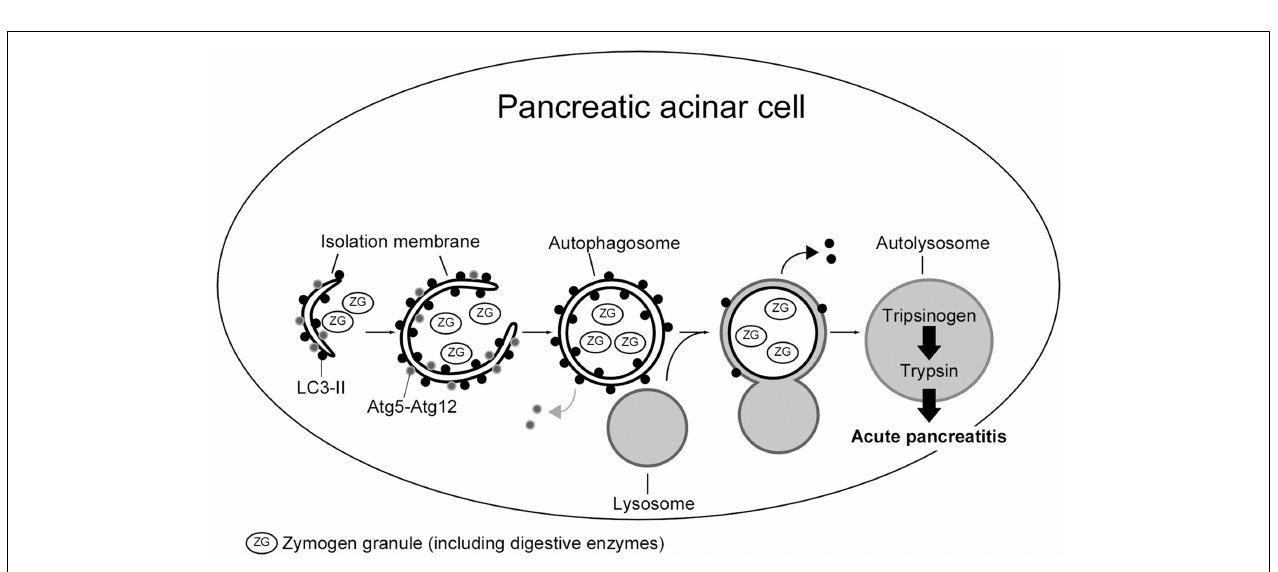
FIGURE 3 | Scheme of autophagy in mammalian cells. A portion of cytoplasm is enclosed by isolation membrane to form an autophagosome. Autophagosome fuses with lysosome to degrade the inside materials.The Atg5–Atg12 conjugate localizes to the isolation membrane throughout its